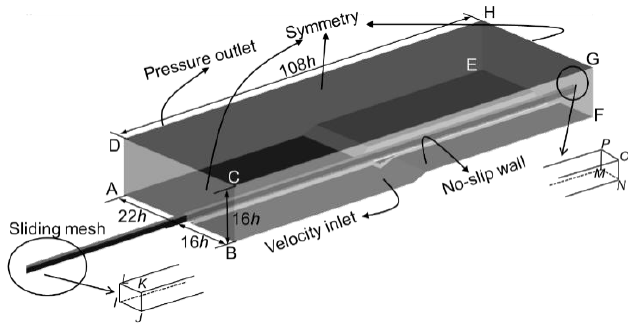
Figure 4. Computational domain and boundary